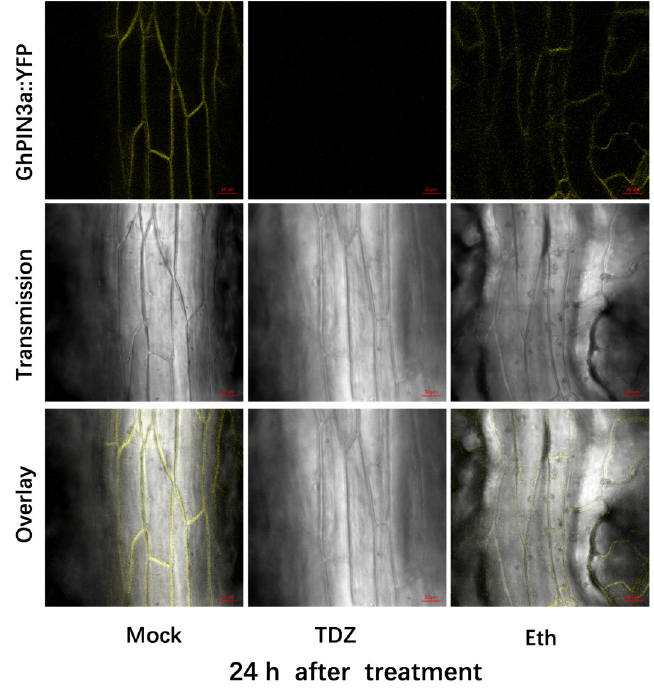
Figure 9. Effect of thidiazuron (TDZ, 300 mg/L) and ethephon (Eth, 0.6 mg/L) on GhPIN3a::YFP expression and protein localization in vein epidermal cells of the fourth leaf from bottom of cotton plants at six-leaf stage.